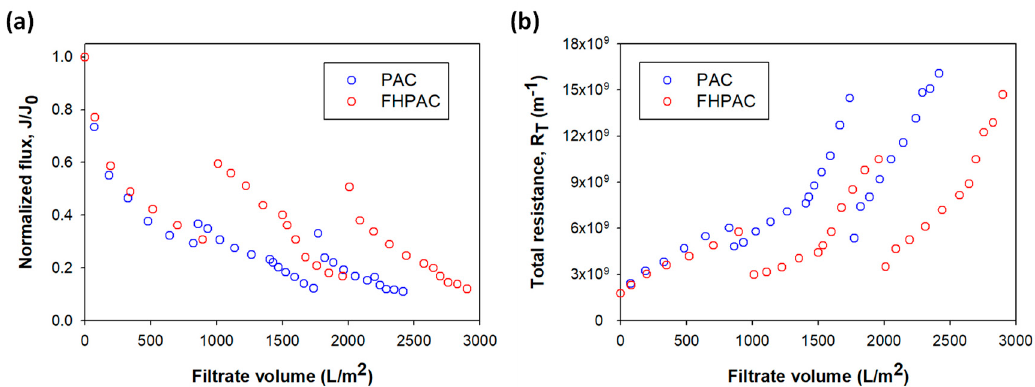
Figure 6. ( a ) Normalized filtrate flux (J/J 0 ) and ( b ) total hydraulic resistance of UF membranes (R T ) subjected to the presence of PAC and FHPAC. J and J 0 denote filtrate fluxes at any filtrate volume and at the beginning of filtration, respectively.